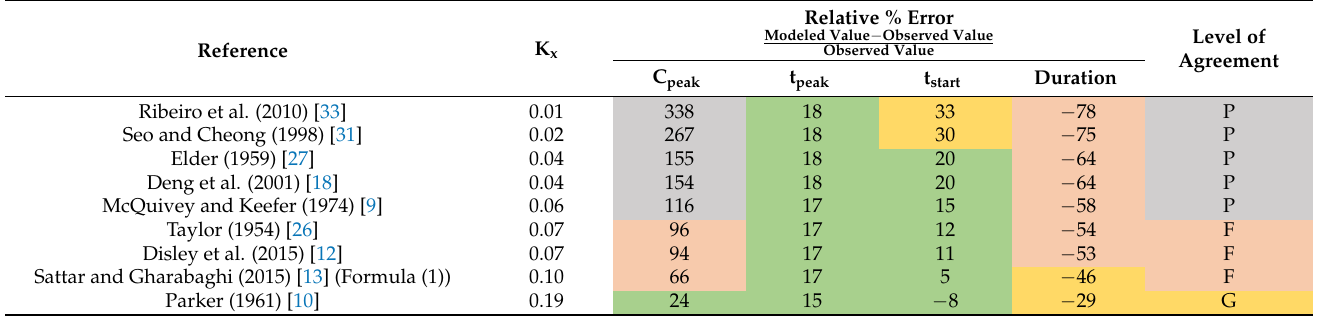
Table 6. Relative error according to predictive formulae in the natural channel.